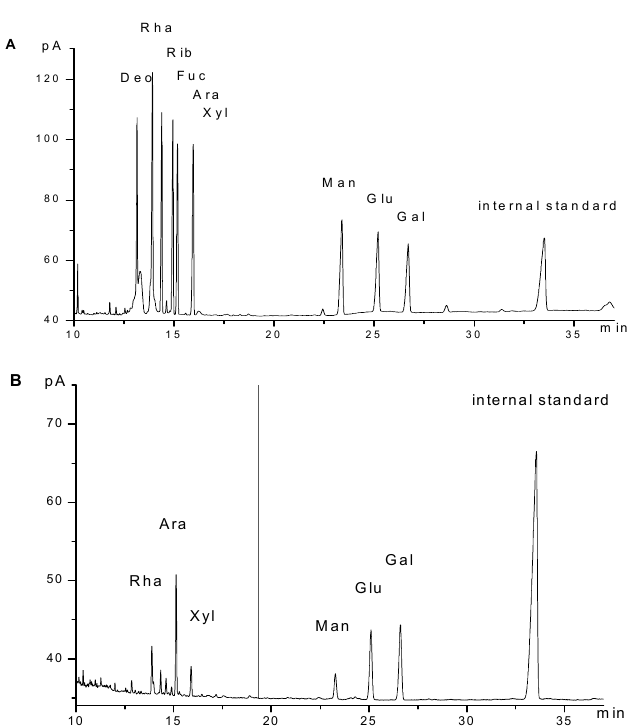
Figure 3. GC chromatograms of nine standard monosaccharides ( A ); component monosaccharides released from GPMPP; ( B ). D -deoxyribose (Deo), L -rhamnose (Rha), D -ribose (Rib), L -fucose (Fuc), D -arabinose (Ara), D -xylose (Xyl), D -mannose (Man), D -glucose (Glu), D -galactose (Gal).